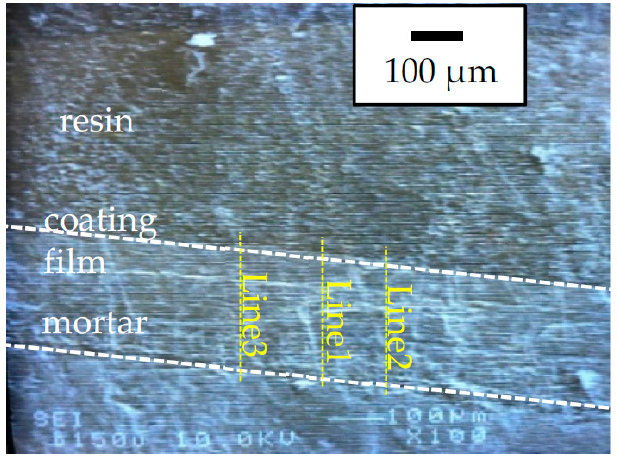
Figure 1. Microscopic image of the sample with three lines describing where EPMA line analysis was